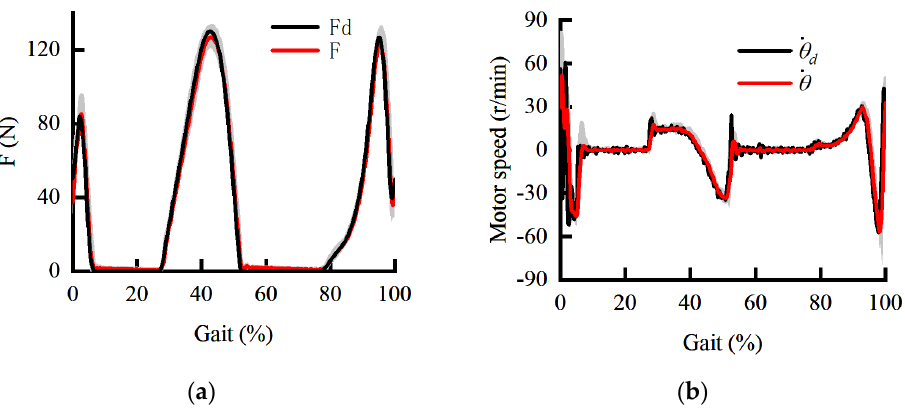
Figure 11. The dynamic curve under the HEIF in the outer loop and DOB in the inner loop. ( a ) The dynamic curve of force response; ( b ) the dynamic curve of speed response.